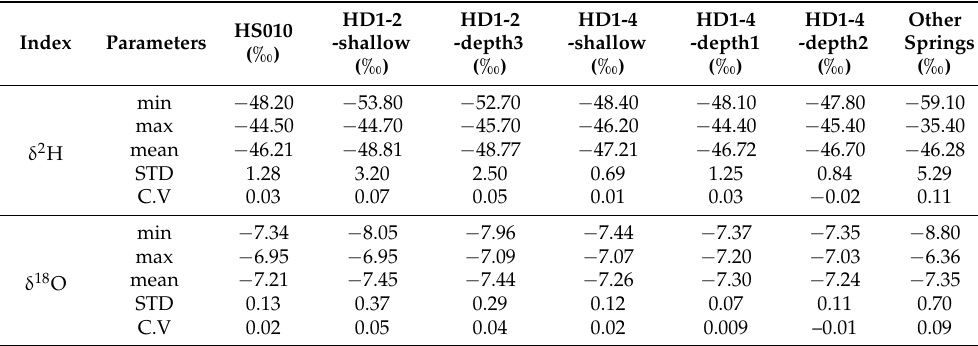
Table 3. Statistics for δ 2 H and δ 18 O